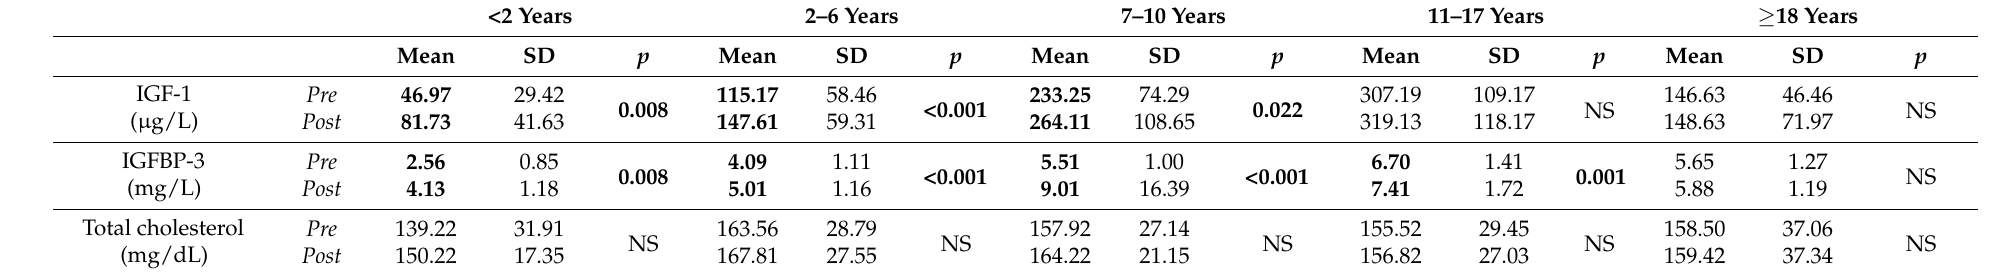
Table 3. IGF-I and IGFBP-3, lipoproteins, and carbohydrate metabolism before and after the lockdown in March–April 2020. p -values > 0.05 depicted as